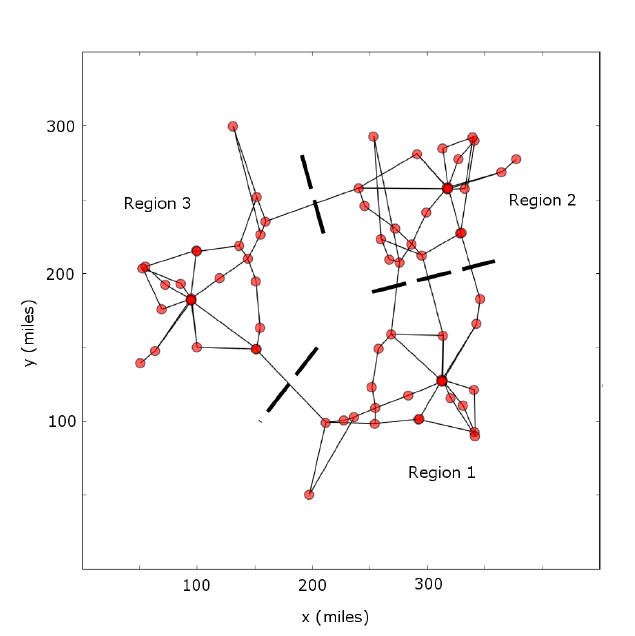
Figure 6. The transmission grid of the RTS-GMLC (Reliability Test System—Grid Modernization Lab Consortium) is divided into three